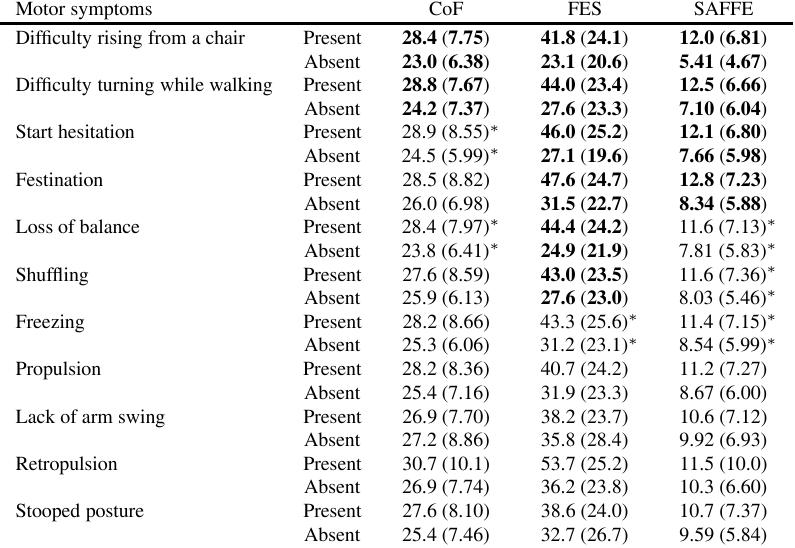
Table 3 Mean (SD) scores on the CoF, FES, and SAFFE according to the presence/absence of speci fi c mobility problems. Comparisons that reach signi fi cance at the Bonferroni corrected criterion of p < 0.0045 are shown in bold, p < 0.05 are marked “ ∗ ”. Signi fi cance for FES is based on tests of log-transformed FES